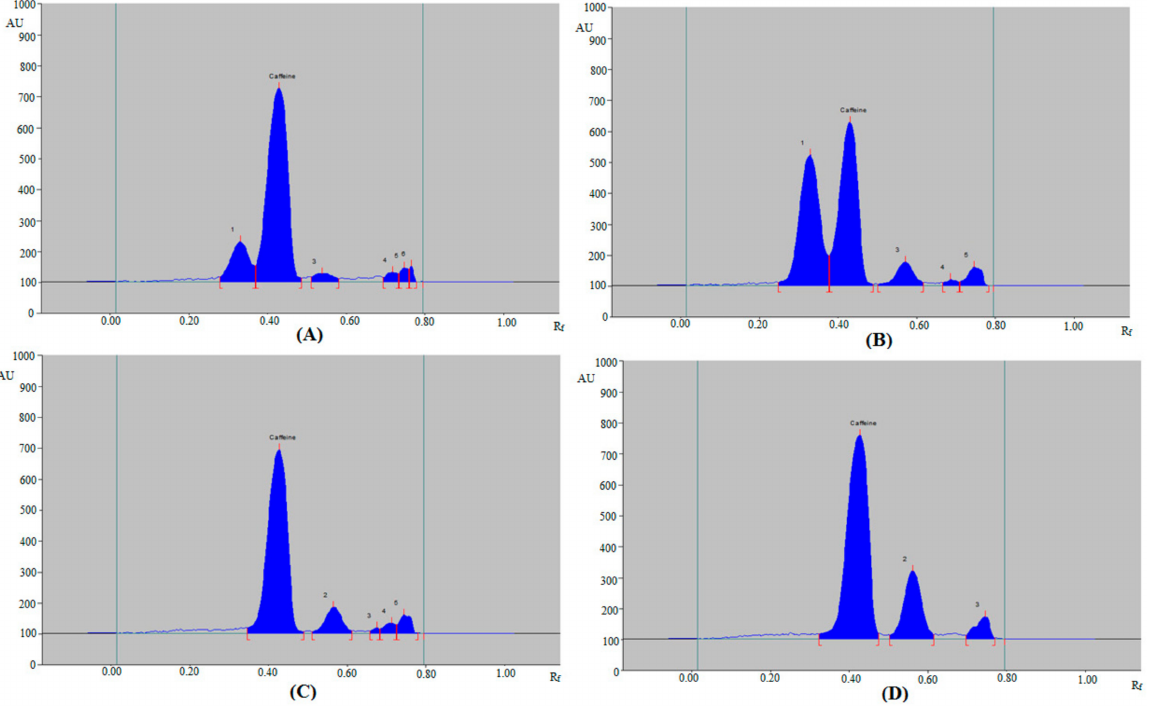
Figure 4. Representative chromatograms of caffeine in ( A ) ED-3, ( B ) ED-6, ( C ) ED-8, and ( D ) ED-10.